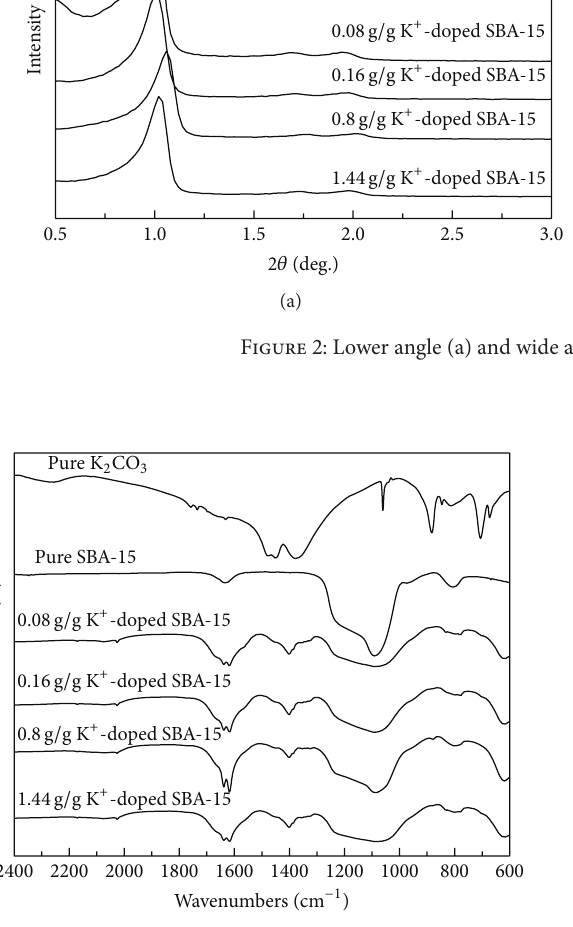
Figure 3: IR spectra of the